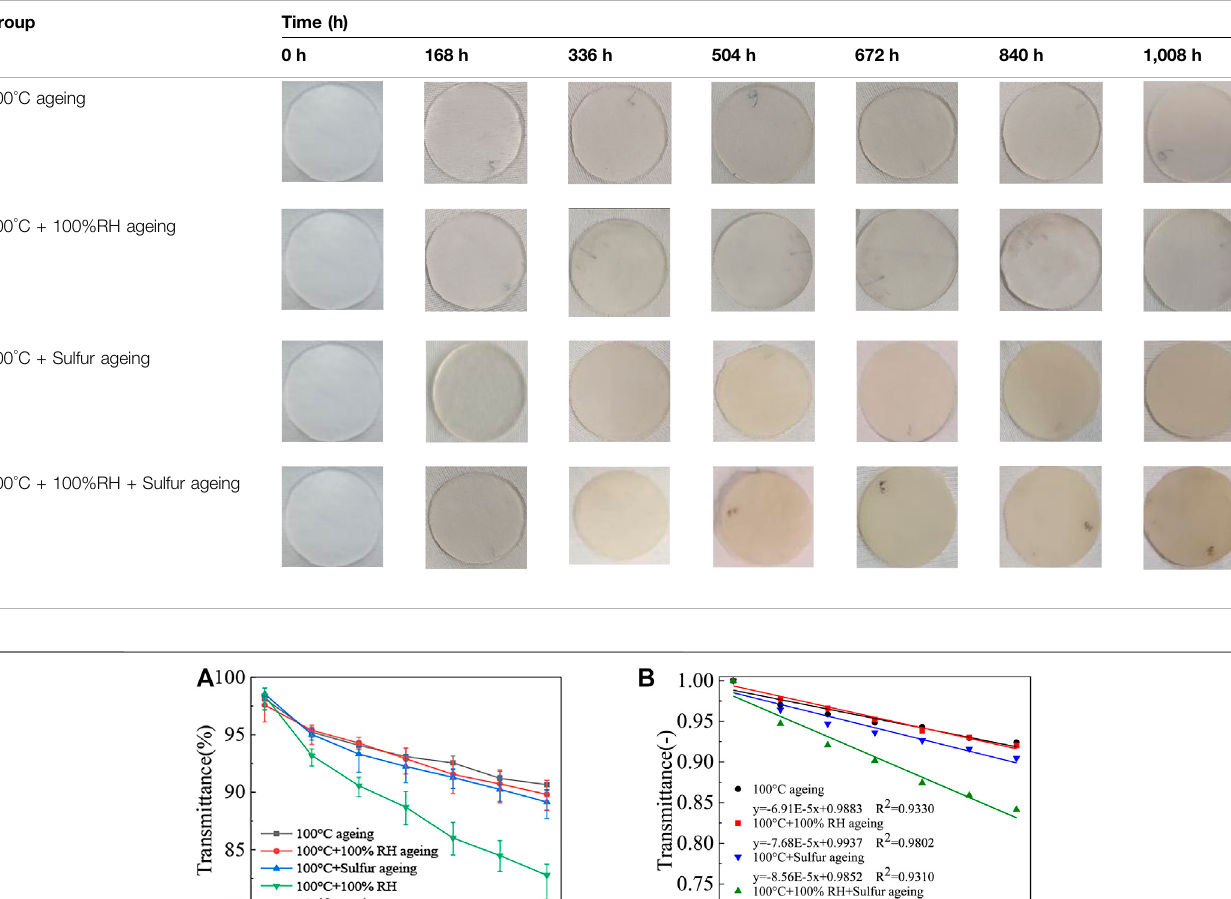
TABLE 1 | Appearance observed in test samples subjected to four different ageing conditions. Group